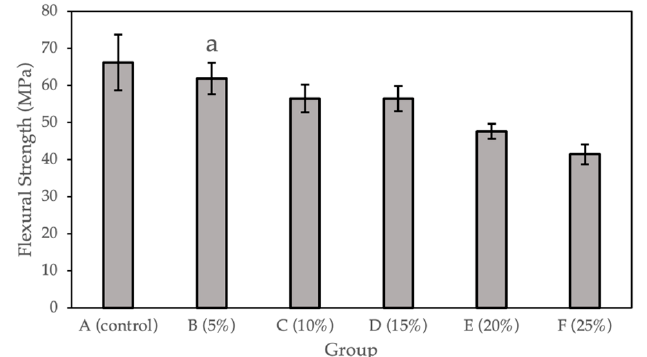
Figure 2. Flexural strength for self-cure PMMA with various Gantrez concentrations ( n = 12). Note: the letter a represents the absence of a statistically significant difference between the mean of the sample group compared to the flexural strength control ( p > 0.05).